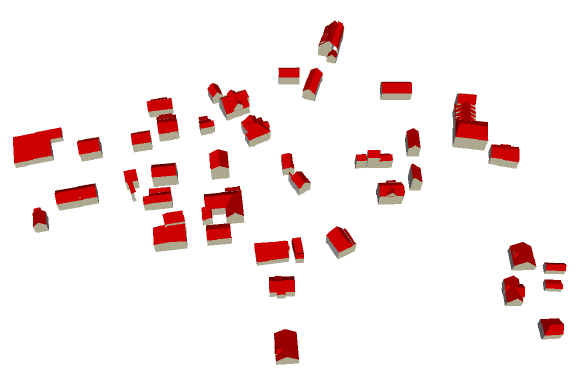
Fig 2.2: 3D scene automatically reconstructed from UAV data.